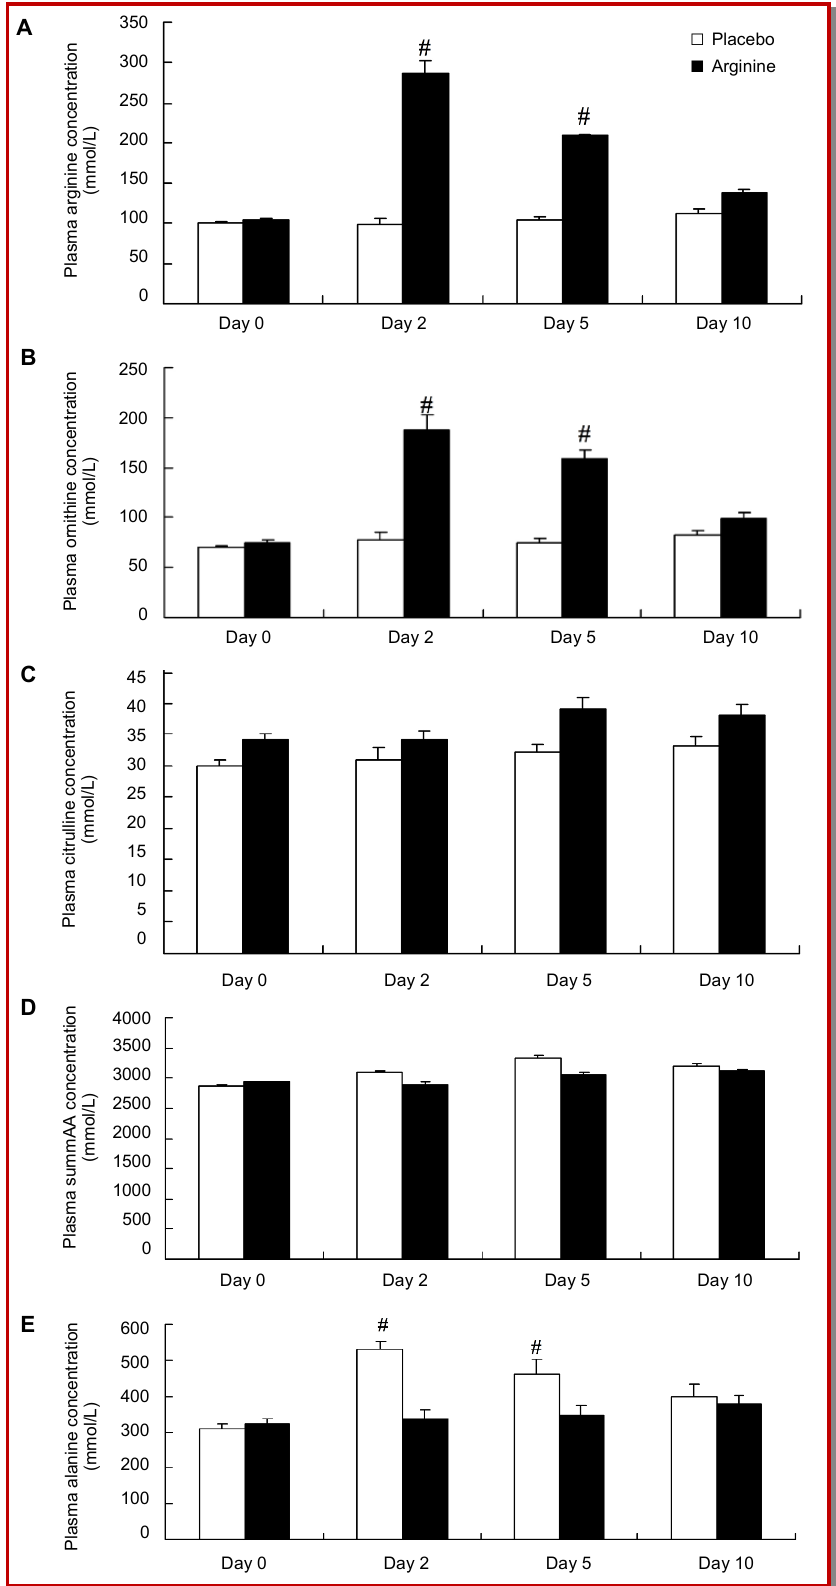
Figure 1: Plasma arginine (A), ornithine (B), citrulline (C), sumAA (D), and alanine (E) concentrations; # p<0.05 compared with 0